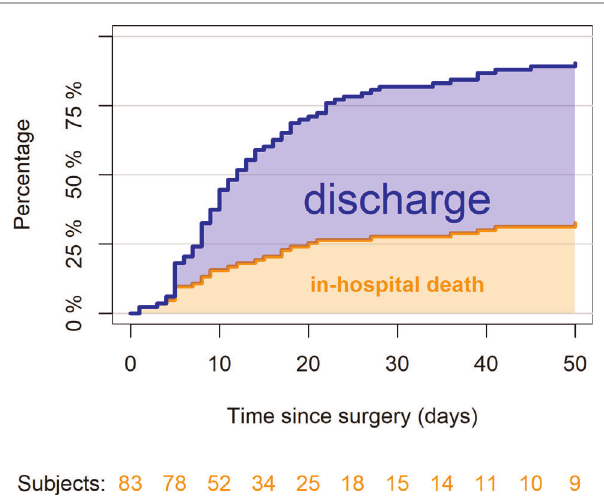
FIGURE 1 | Percentages of patients who died in hospital or who were discharged by the time since surgery ( n =83). At 30 days since surgery, 23 patients (28%, 95% CI, 18 – 37%) died, 45 (54%, 95% CI, 44 – 65%) were discharged and the remaining 15 were still recovering in hospital. The con fi dence limits are explained in a supplementary table ( Table 7